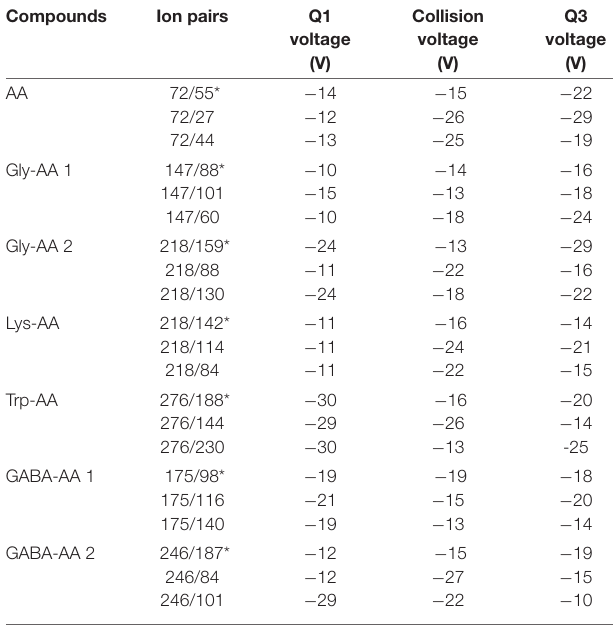
TABLE 1 | Condition of column chromatography and semi-preparative LC. Reaction